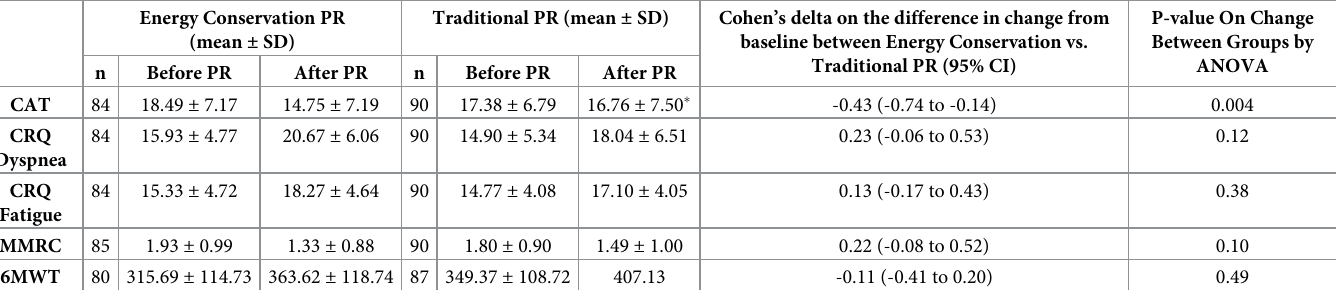
Table 2. Comparison between energy conservation and traditional pulmonary rehabilitation on patient outcomes.